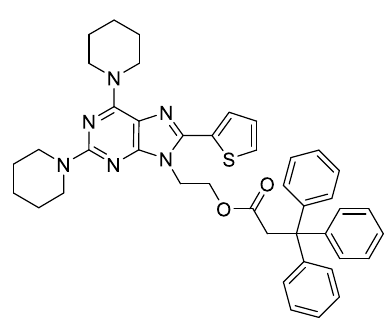
Supplementary Materials: The following are available online. 1 H- and 13 C-NMR spectra of 2-(2,6-dichloro-9 H -purin-9-yl)ethyl 3,3,3-triphenylpropanoate ( 3 ), 2-[2,6-di(piperidin-1-yl)-9 H -purin-9-yl]ethyl 3,3,3-triphenylpropanoate ( 4 ), 2-[8-bromo-2,6-di(piperidin-1-yl)-9 H -purin-9-yl]ethyl